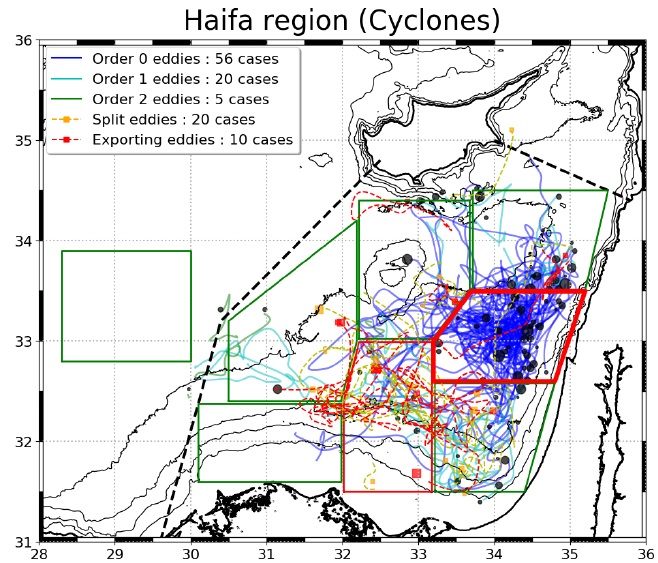
Figure A3. Cyclone transfers for Haifa region. Same as Fig. 6c but with the Lagrangian convergence framework applied to cyclones. Boxes and dashed line are the same as in Fig. 3.